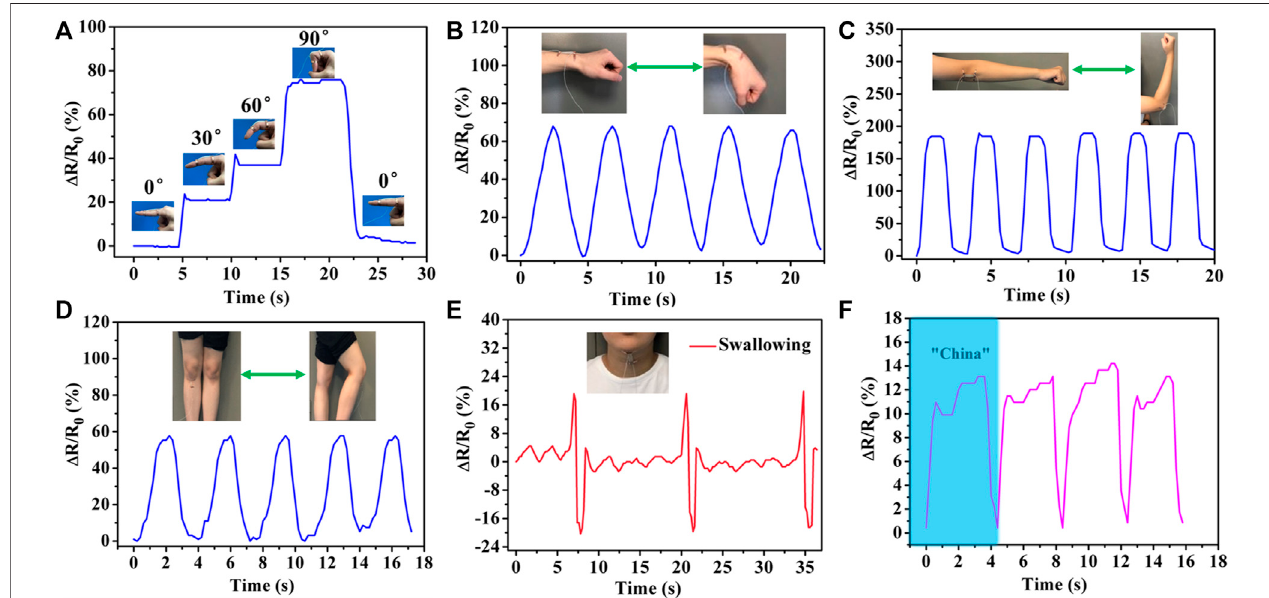
FIGURE7| Real-timemonitoring ofhumanphysicalactivitiesbasedon wearable PHEAA-GE-Gl-LiClorganohydrogel sensor. Relativeresistance changes( Δ R/R 0 ) ofdifferenthumanjointmotions: (A) fi ngerbendingatdifferentangles, (B) wristjointbending, (C) elbowjointbending, (D) kneejointbending.Detectionofsubtlemotions of (E) swallowing and (F) pronouncing word “ China.